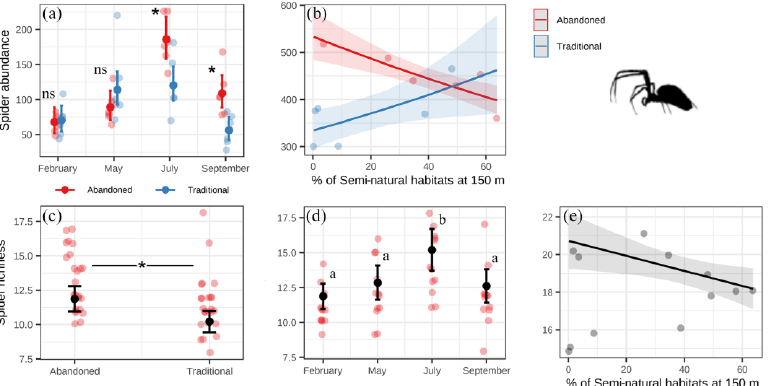
Figure 4. Results of the linear models for spider abundance ( a , b ) and richness ( c – e ). Points with error bars represent estimated means and 95% confidence intervals from the models’ predictions, and dull dots represent the raw data. Significant differences ( p < 0.05) are shown with asterisks. Differences in pairwise comparisons are shown with different letters. ns: not significant.